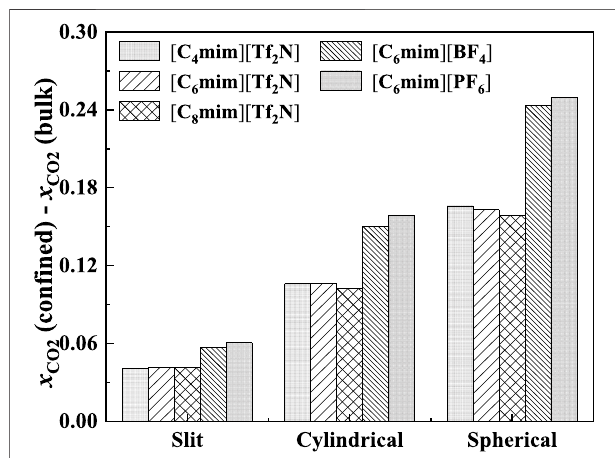
FIGURE 16 | Calculated additional solubilities of ILs con fi ned in different shaped pores at 298.15 K and 1 bar in50 Å.Solid symbols, datafor con fi ned ILs; open symbols, data for bulk